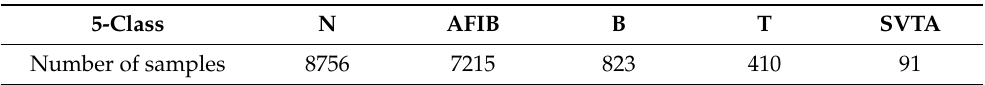
Table 1. Number of samples in the 5-class dataset used to classify ECG rhythms with few samples. Abbreviations are defined in the